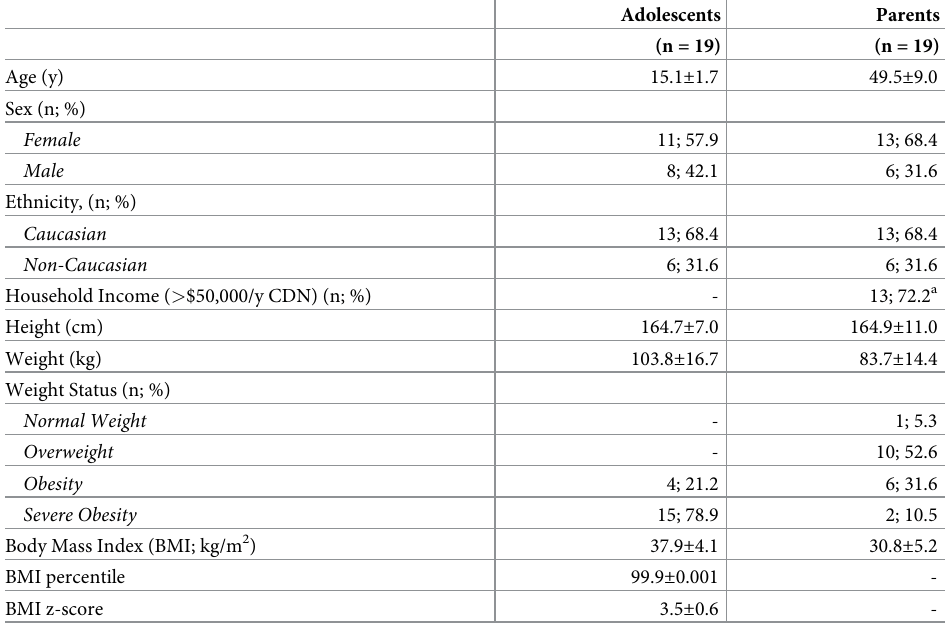
Table 2. Demographic, anthropometric, and sociodemographic characteristics of adolescents and their